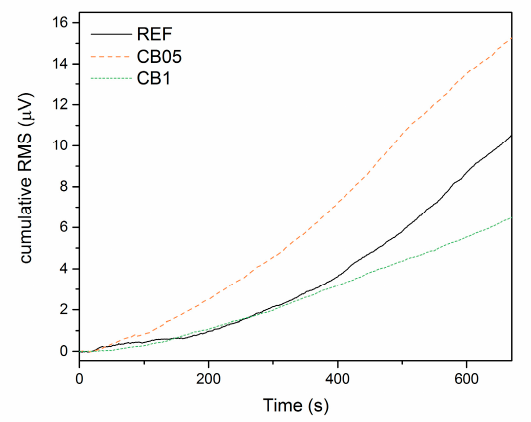
Figure 4. Comparison of cumulative RMS recorded for samples REF, CB05 and CB1 during re- peated loading.